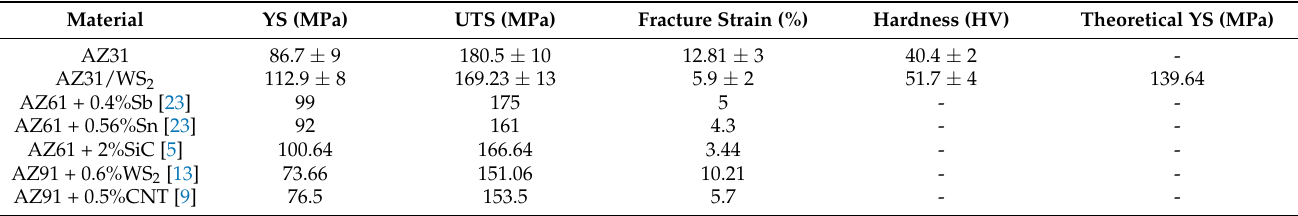
Table 2. Mechanical properties of the AZ31/ WS 2 nanocomposite.